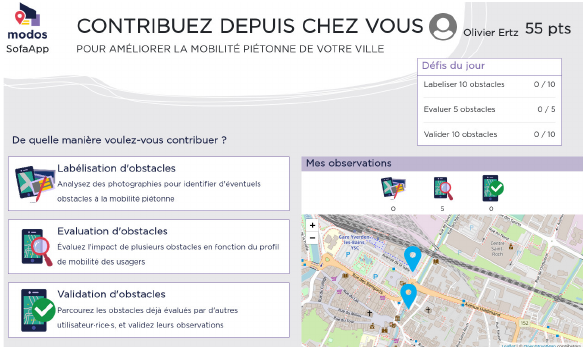
Figure 1. Start page of the sofa web app allowing to perform labelling, evaluation of impact and